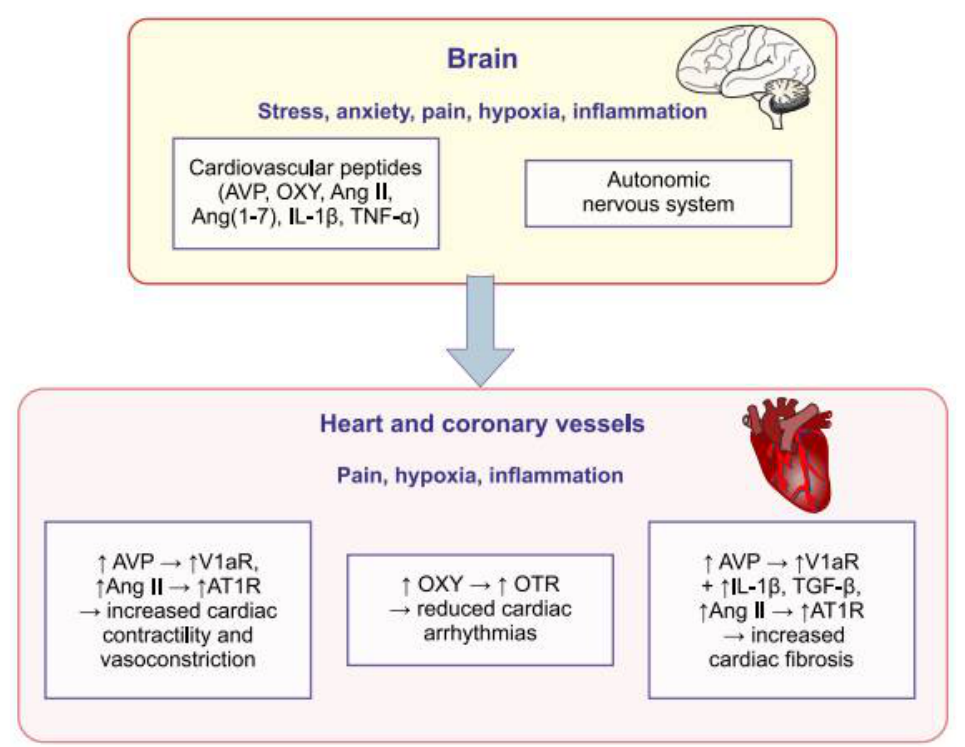
Figure 2. Interaction of vasopressin, angiotensins, oxytocin and cytokines with the autonomic nerv- ous system in the regulation of cardiovascular parameters. Stress, anxiety, pain, hypoxia and inflam- mation enhance the release of vasopressin, oxytocin, angiotensins and cytokines in the brain, heart and vessels, and these peptides regulate the function of the heart and vessels through central and intracar-